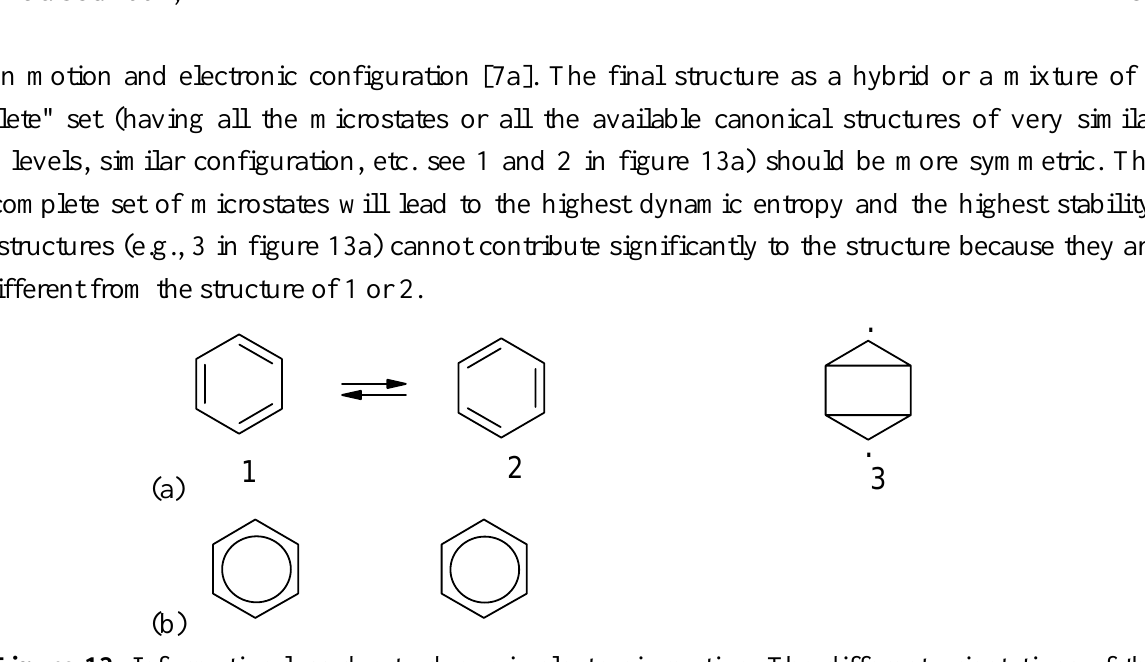
Figure 13. Information loss due to dynamic electronic motion. The different orientations of the valence bond benzene structures 1 and 2 in (a) can be used for recording information. However, the oscillation makes all the individual benzene molecules the same as shown in